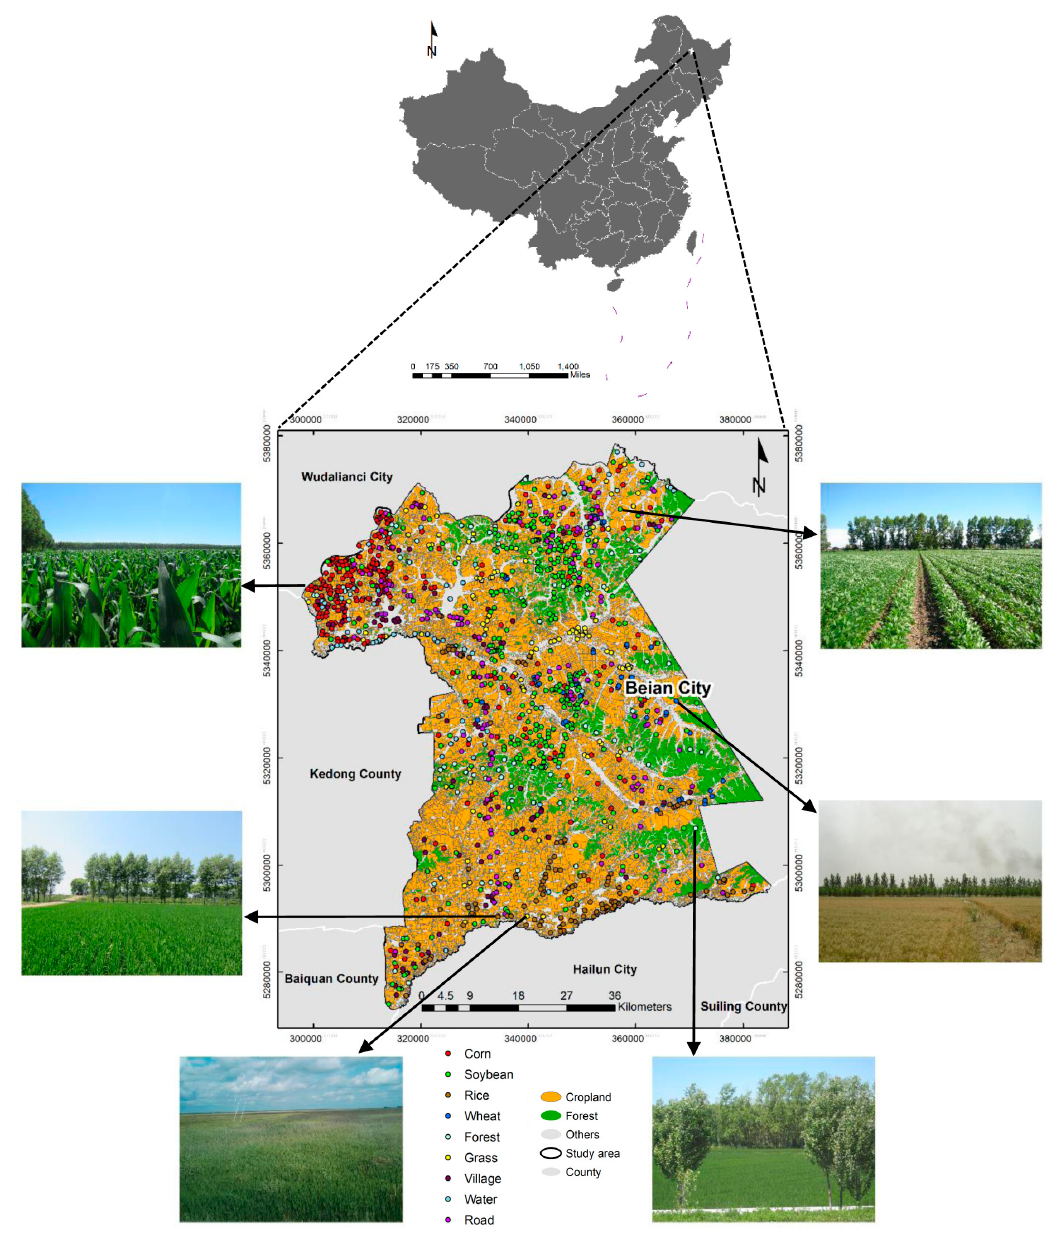
Figure 1. Location of the study area and the sampling points in summer.